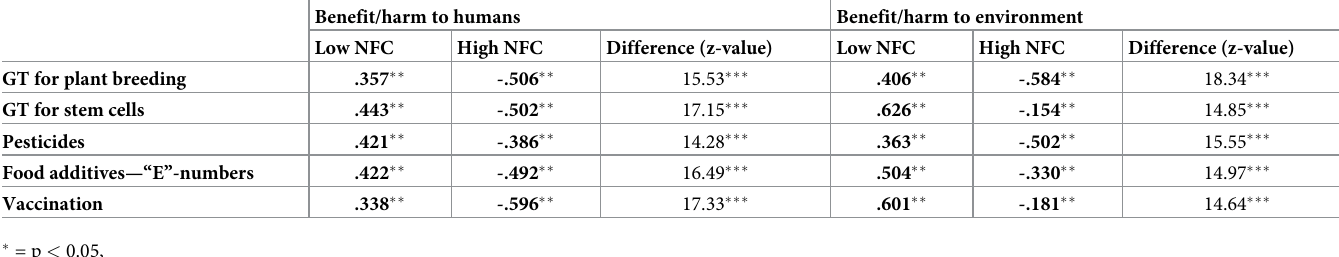
Table 2. Pearson’s correlations between benefit and harm for the low and high NFC groups; the significance of differences in pairs of correlation coefficients tested using fisher r to z transformation. Benefit/harm to